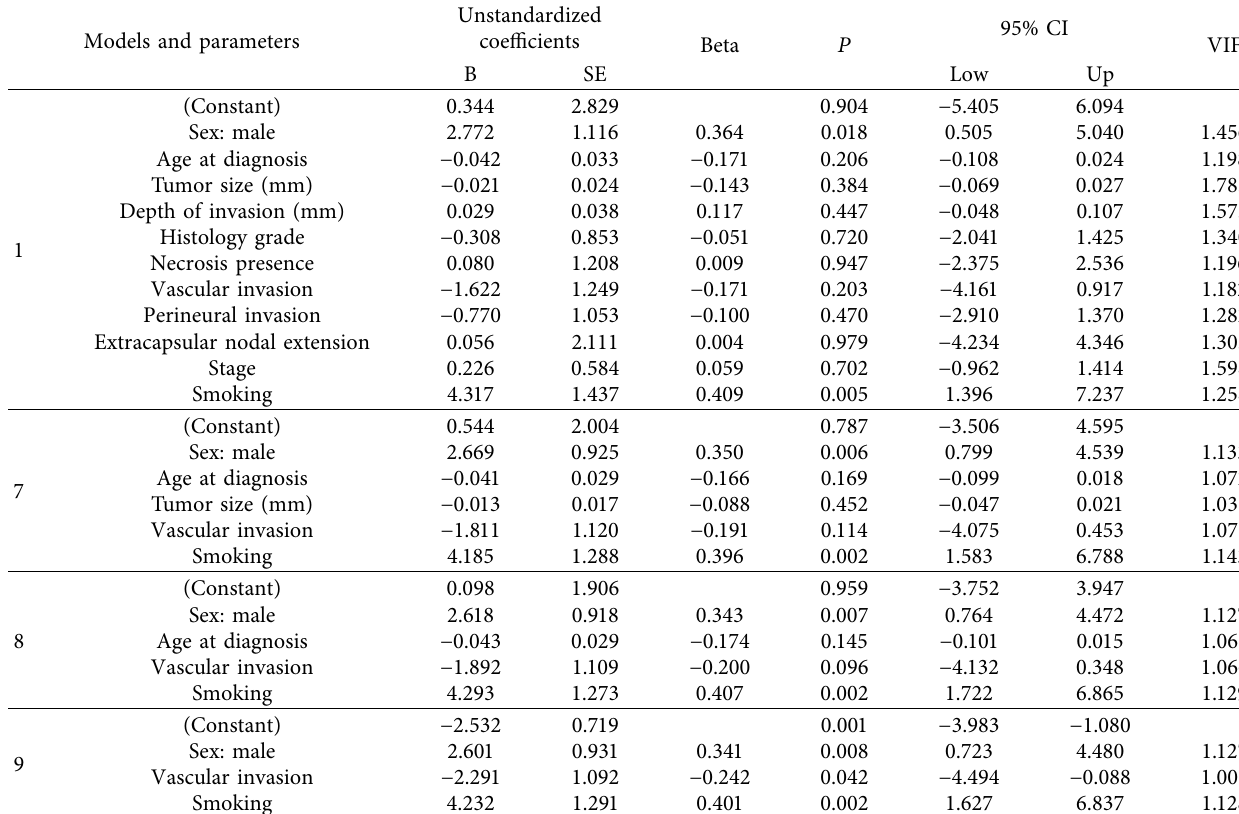
Table 3: Factors associated with the ΔΔ Ct CD57, calculated using the backward-selection stepwise log-level multiple linear regression. Models and parameters